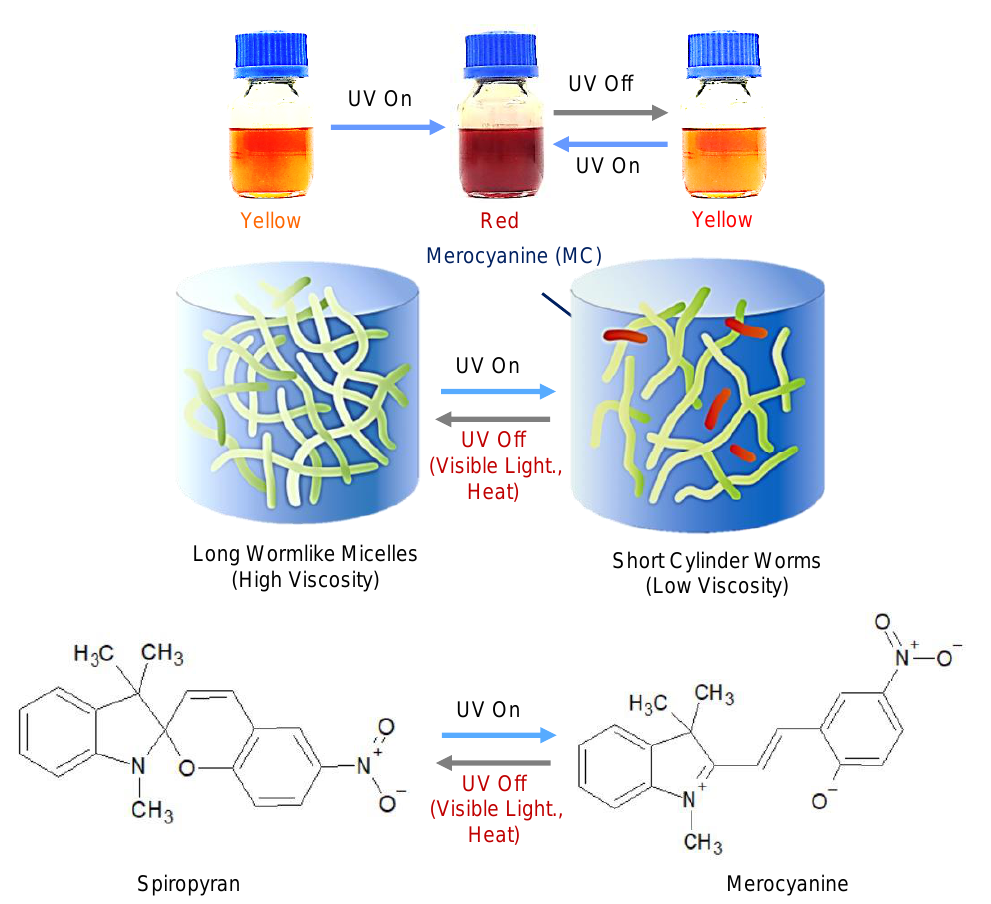
Figure 1. Photo-rheological (PR) phenomenon of wormlike reverse micelle-based PR fluid and the chemical structures of spiropyran (SP) and merocyanine. Table 1. List of the three primary ingredients of PR fluid samples in 100 mL of cyclohexane.